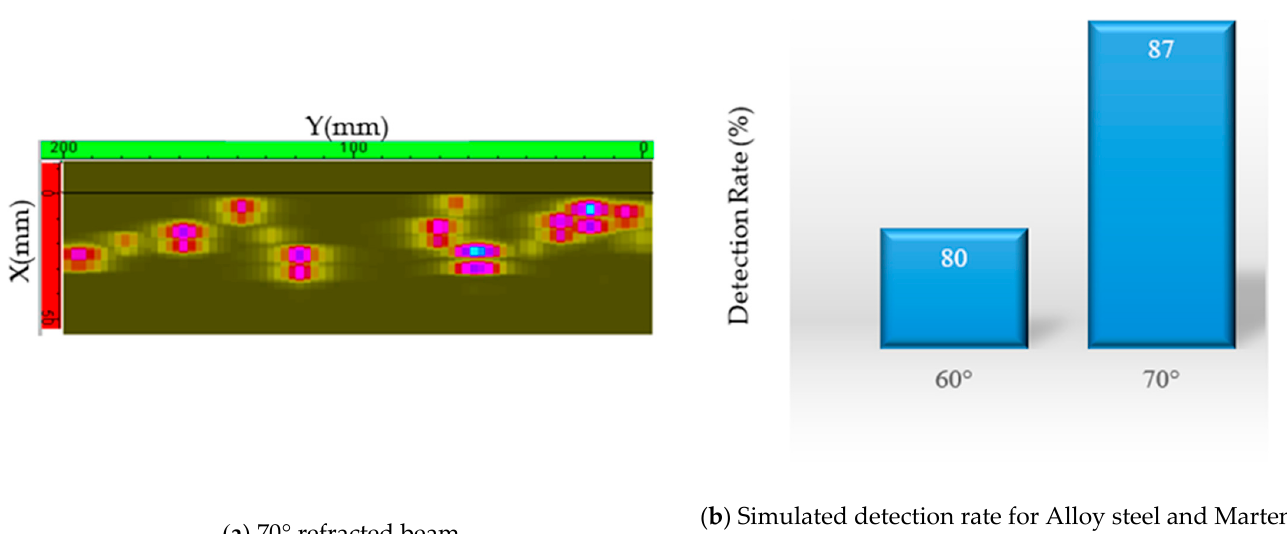
Figure 9. Scanning pattern and material properties